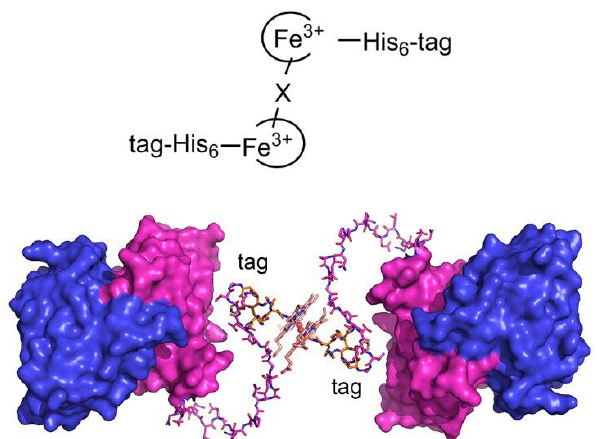
Scheme 2. Proposed model of HupZ-heme complex with X representing a bridging ligand, and an example of which is illustrated in a cartoon constructed from the homodimeric form of the